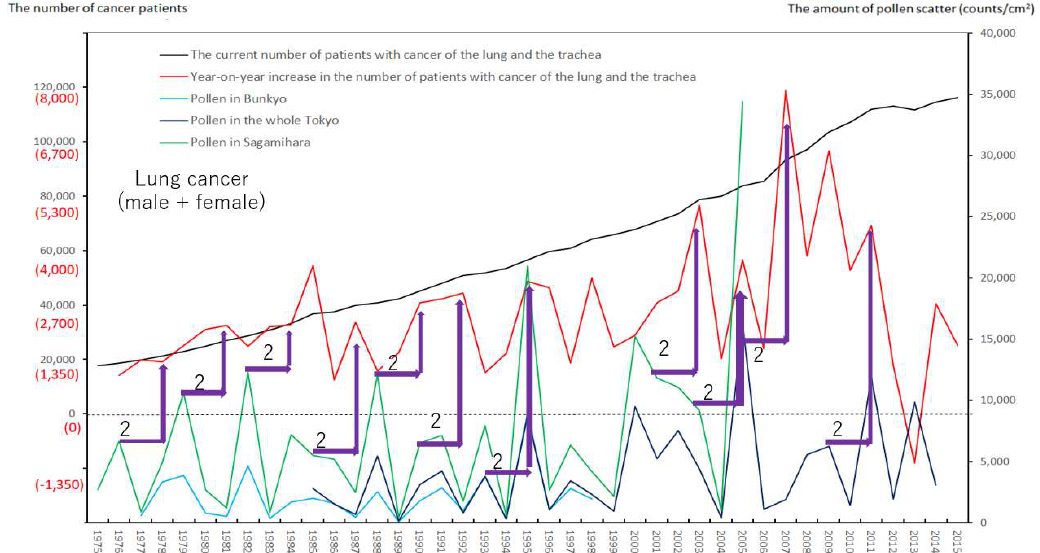
Figure 2. The current number of Japanese males and females (presently registered patients) registered for cancer of the lung and the trachea at the year diagnosed, its year-on-year increase (newly registered patients), and the amount of air borne pollen scatter in 3 areas during the period from 1975 to 2015. The line graphs for males and females with cancer of the lung and the trachea representing numbers of presently and newly registered patients in each year, as well as the amount of pollen scattered during the period from 1975 to 2015. Violet arrows indicate phasic increments of newly registered patients occurring two years after phasic increments of airborne pollen